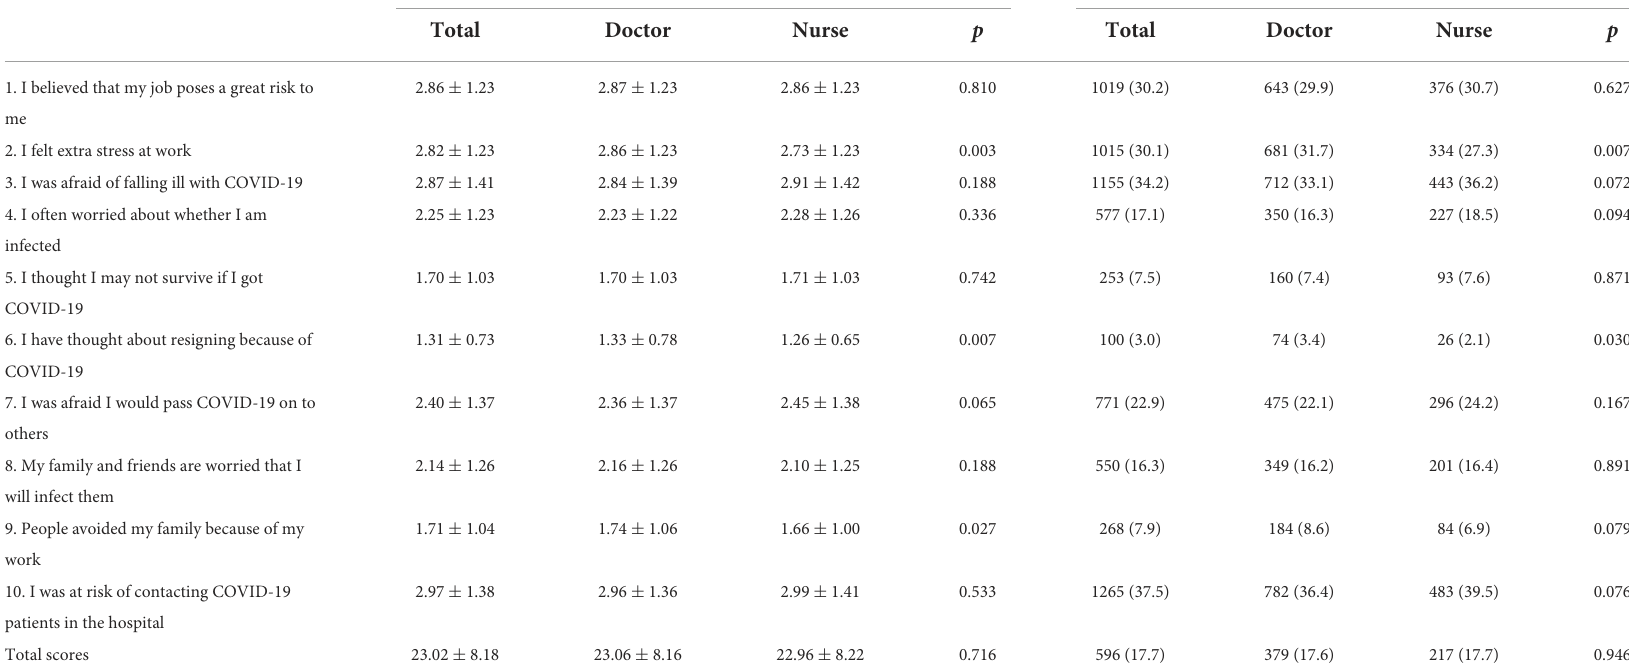
TABLE 3 Risk perception of